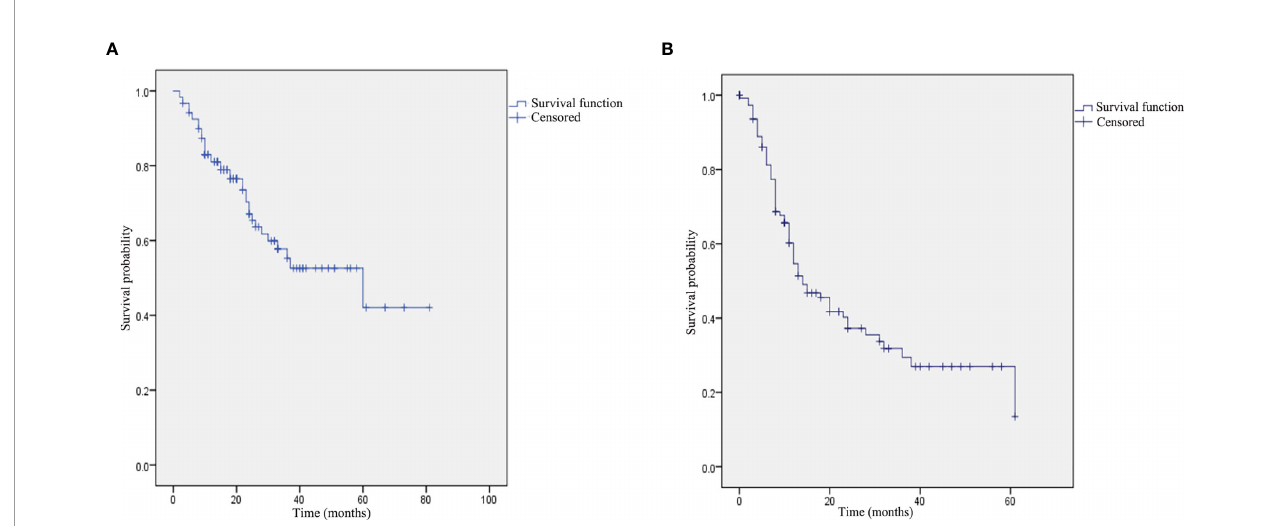
FIGURE 3 | Kaplan – Meier curve pertaining to the survival in patients with advanced recurrent nasopharyngeal carcinoma: (A) overall survival: and (B) progression- free